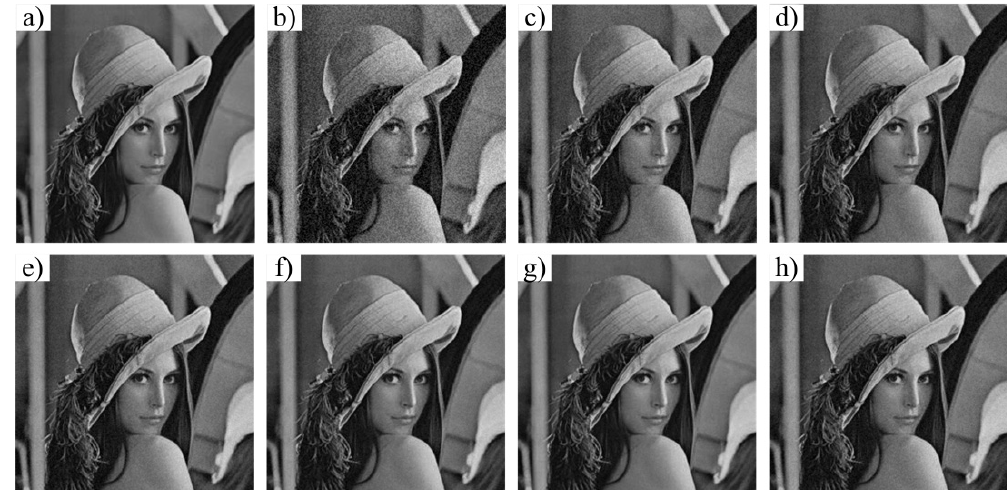
Figure 5. Denoising performance of the six algorithms to the Lena image. ( a ) Original image; ( b ) noisy